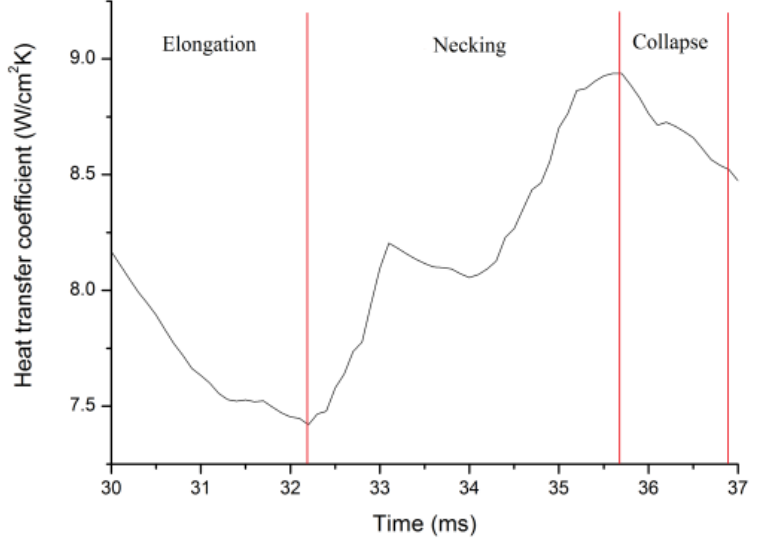
Figure 9. Heat transfer coefficient for a typical cycle[77].